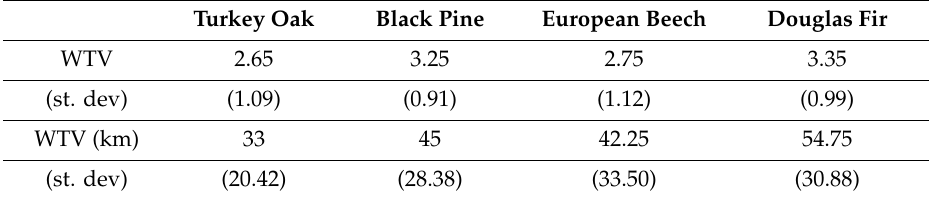
Table 5. Probability to visit forests for stress recovery and willingness to visit (WTV) in km. Turkey Oak Black